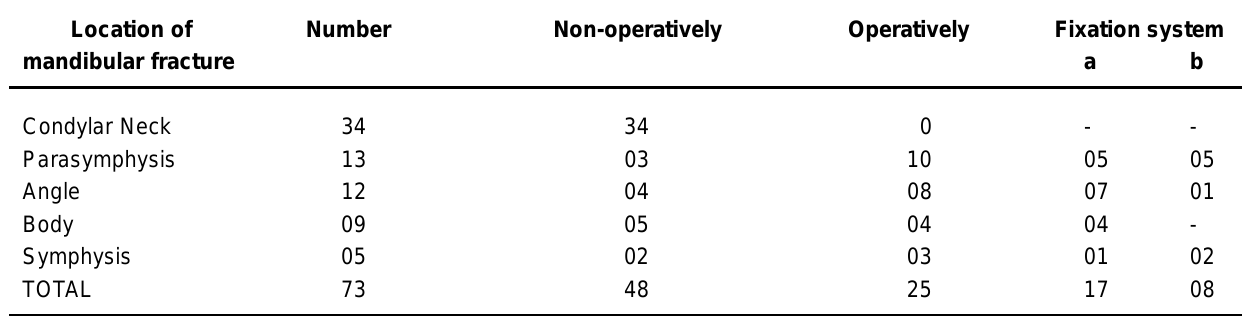
a: Transosseous wiring. b: miniplate